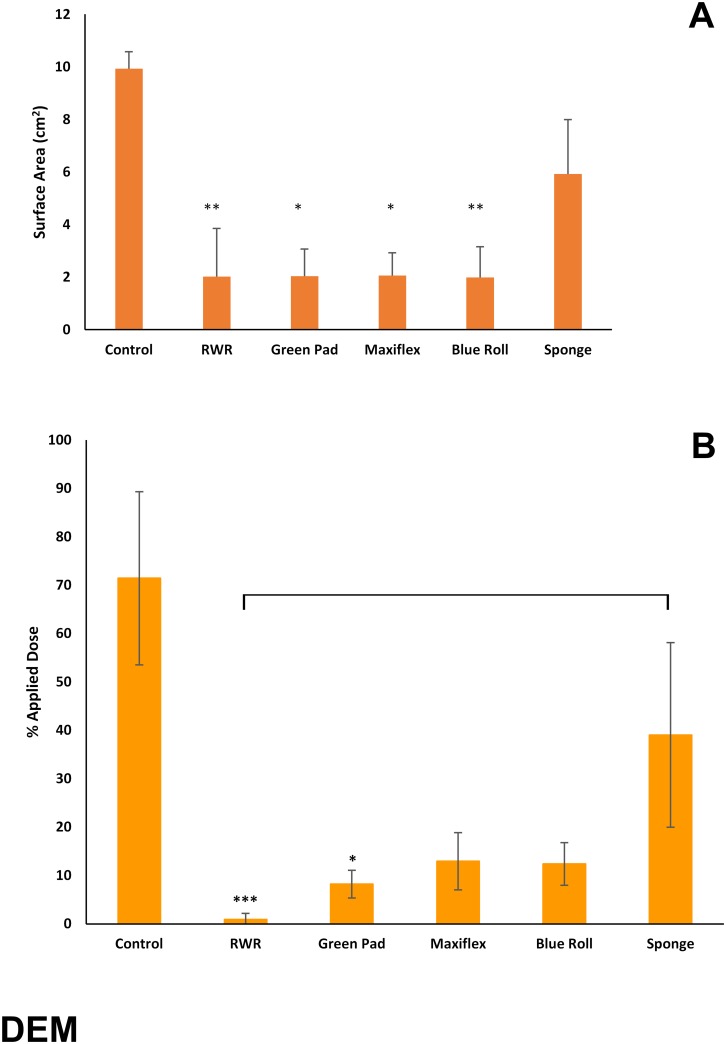
(A) Skin surface spreading and (B) recovery of 14C-diethyl malonate (expressed as percentage of applied dose) remaining on, within or penetrated through dermatomed pig skin following decontamination (after 15 minutes) with test products (green incontinence pads, Maxiflex wound dressing, absorbent tissue paper (blue roll) or polyurethane sponge) or the rinse-wipe-rinse method (RWR).All values are mean ± standard deviation of n = 6 replicates. Asterisks indicate significant differences between treated and untreated (control) skin: *p<0.05; **p<0.01; ***p<0.001. Horizontal brackets indicate significant differences (p<0.05) between treatment groups.